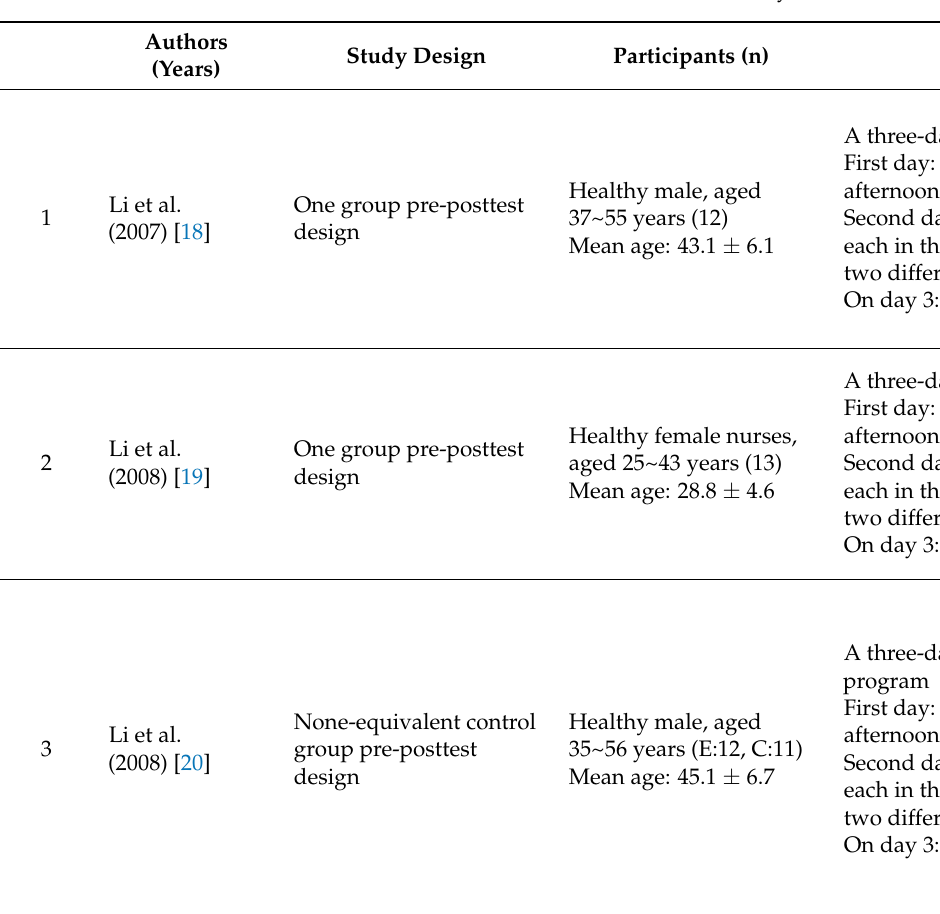
Table 2. Summary of studies included in the systematic review (k =